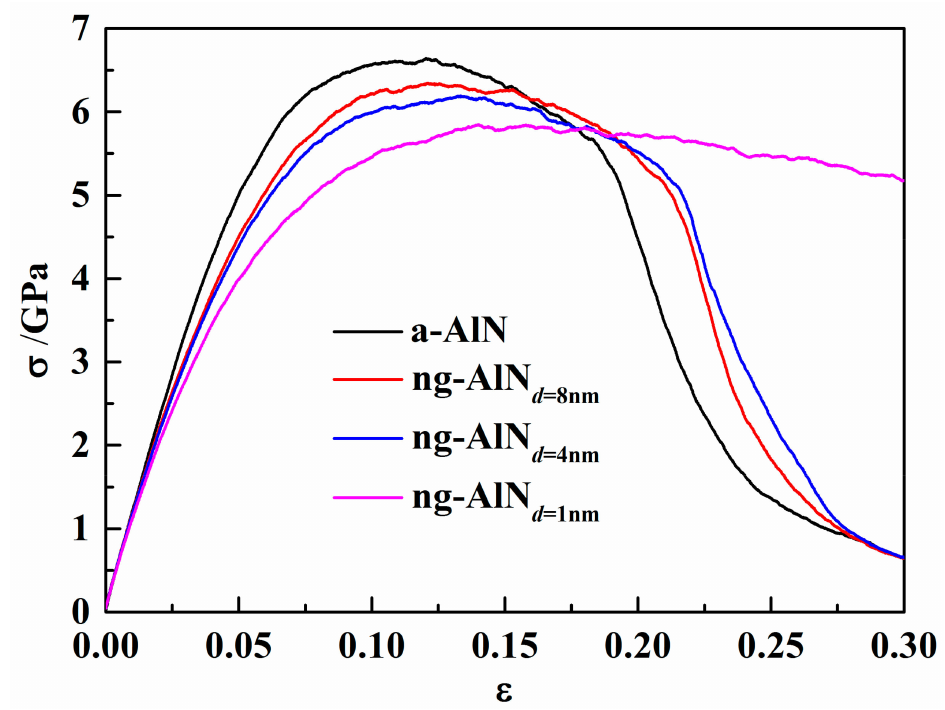
Figure 3. Tensile stress-strain ( σ − ε ) curves for a-AlN and ng-AlNs with average grain size of 8 nm, 4 nm, and 1 nm, respectively.